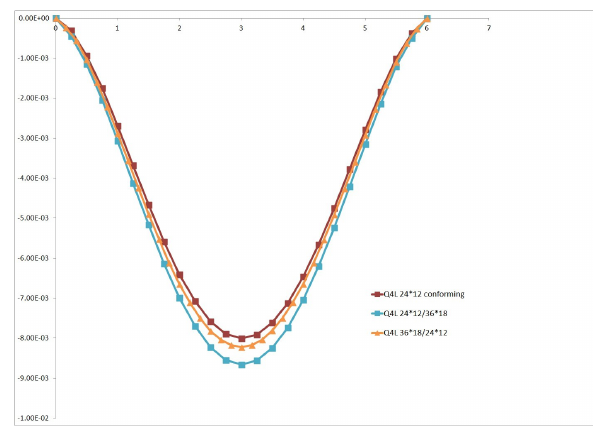
Figure 16: Transverse displacement u 3 distribution for a double- layer shell with Q4 elements and linked interpolation using con- forming and non-conforming mesh